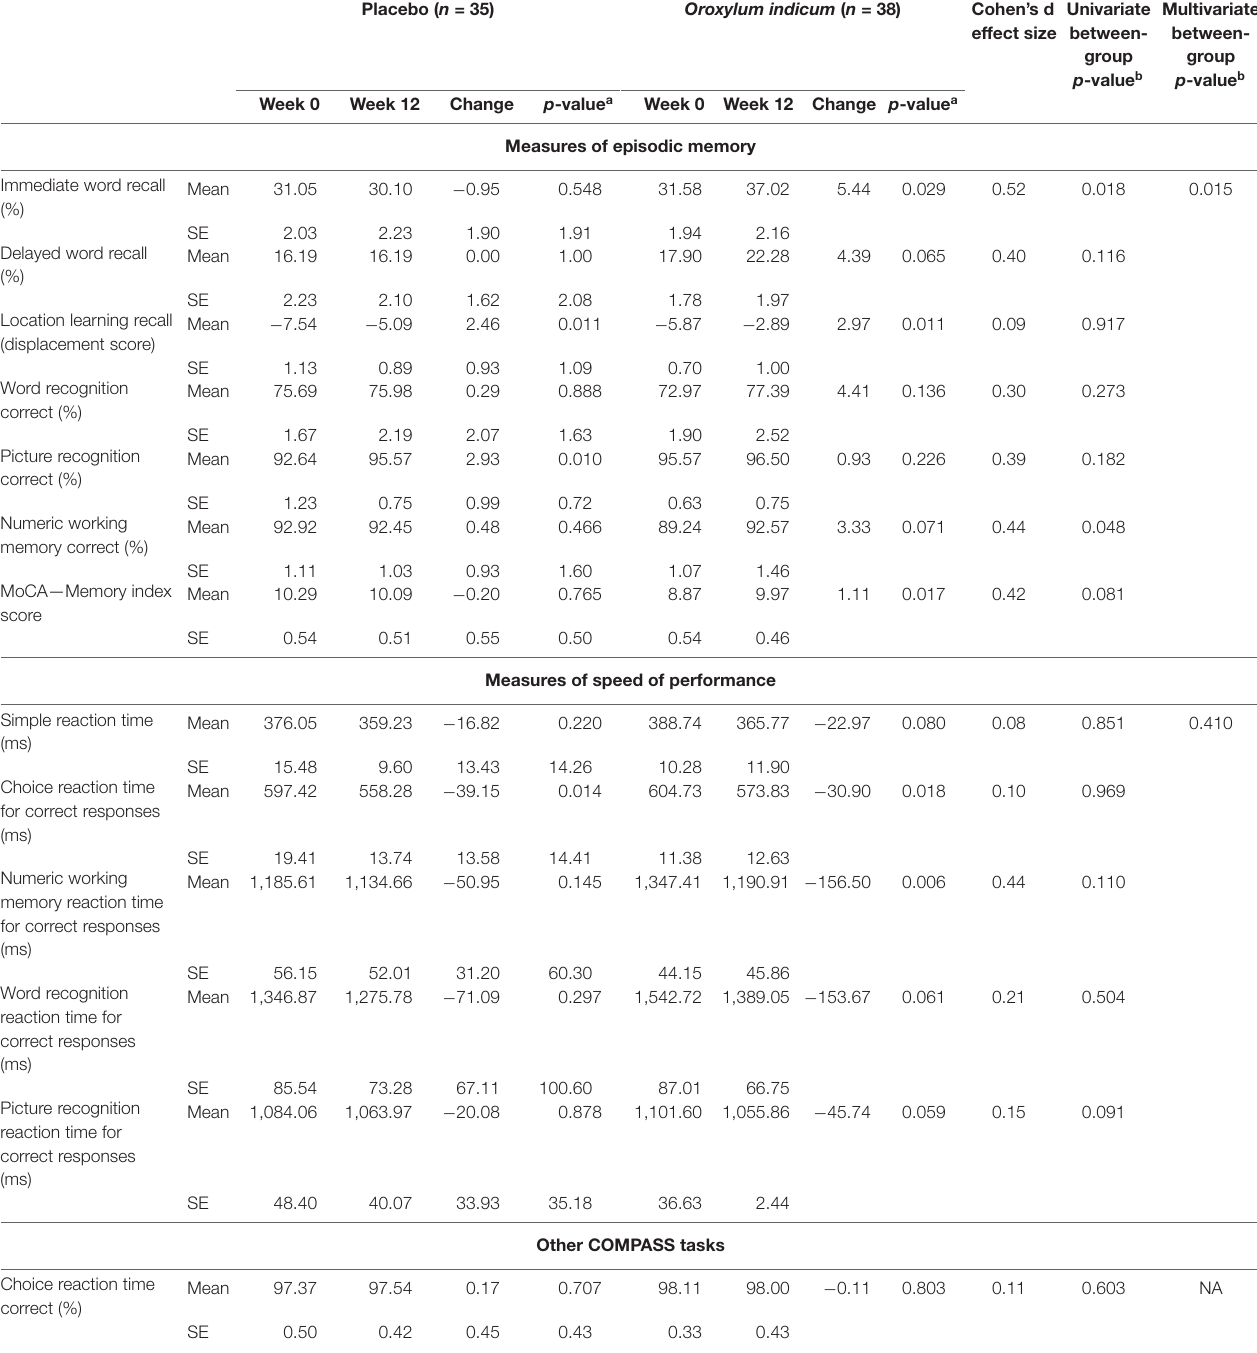
TABLE 4 | Change in COMPASS tasks.